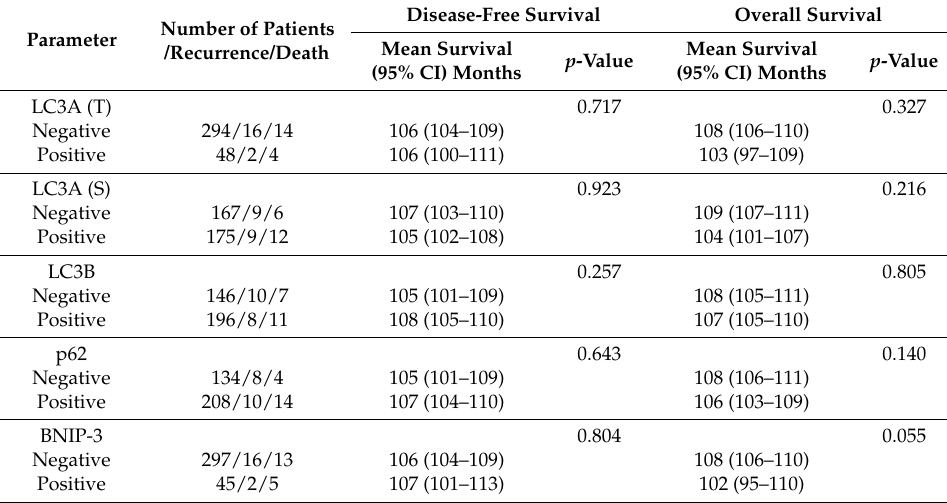
Table 6. Univariate analysis of the influences of autophagy-related protein expression on disease-free and overall survival among patients with papillary thyroid cancer (log-rank